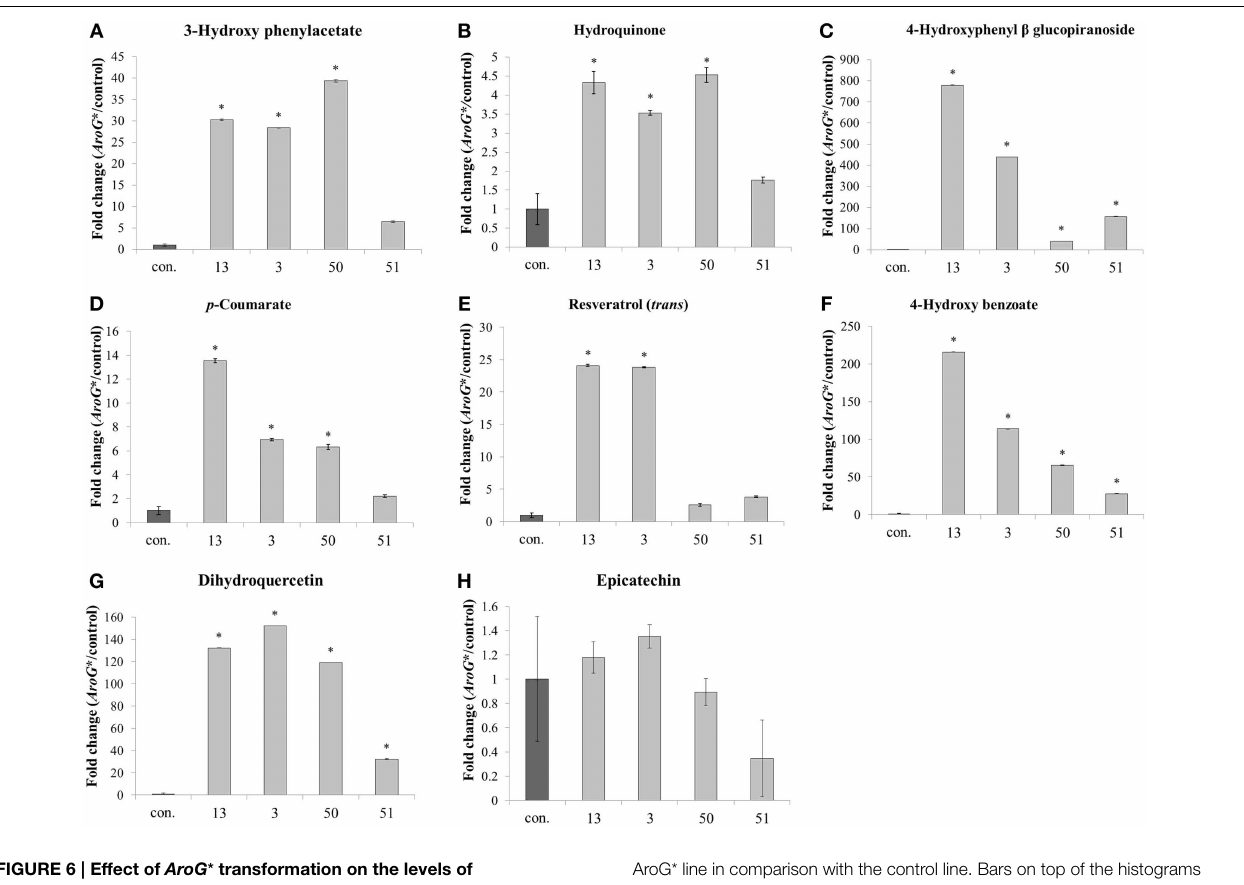
FIGURE 6 | Effect of AroG * transformation on the levels of AAA-derived specialized metabolites. Levels of metabolites [ (A) 3-hydroxy phenylacetate, (B) hydroquinone, (C) 4-hydroxyphenyl β glucopiranoside, (D) p -coumarate, (E) resveratrol, (F) 4-hydroxy benzoate, (G) dihydroquercetin, and (H) epicatechin] are presented as fold change of